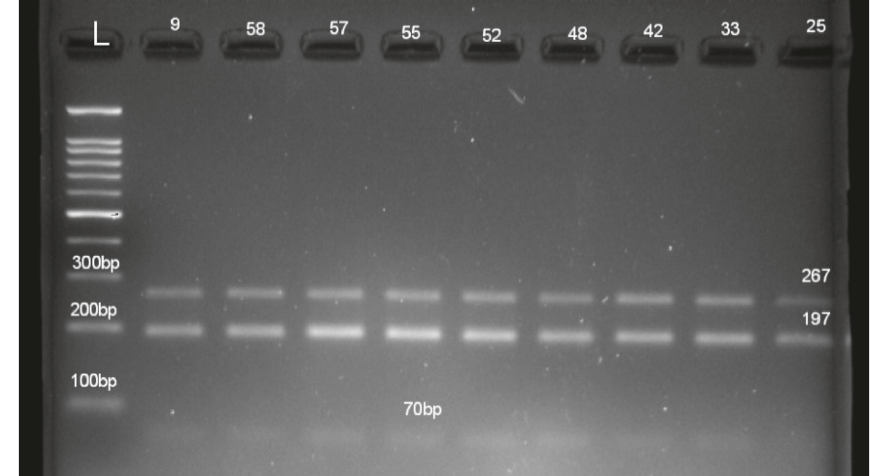
Figure 2: Representing RFLP for FOK1 gene polymorphism. Table 1: Age group and sex distribution of participants.